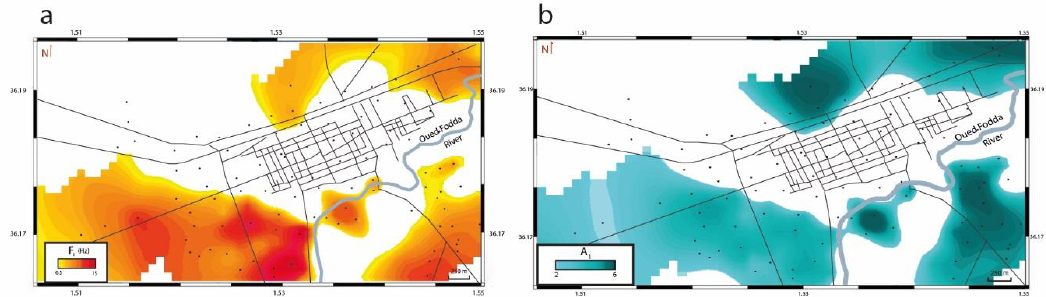
Figure 7. ( a ) Mapping of secondary frequency peaks, f1. ( b ) Corresponding amplification factors obtained from the HVSR analysis. The thick black line is the El-Asnam Fault (EAF). The black grid is the city map and roads.